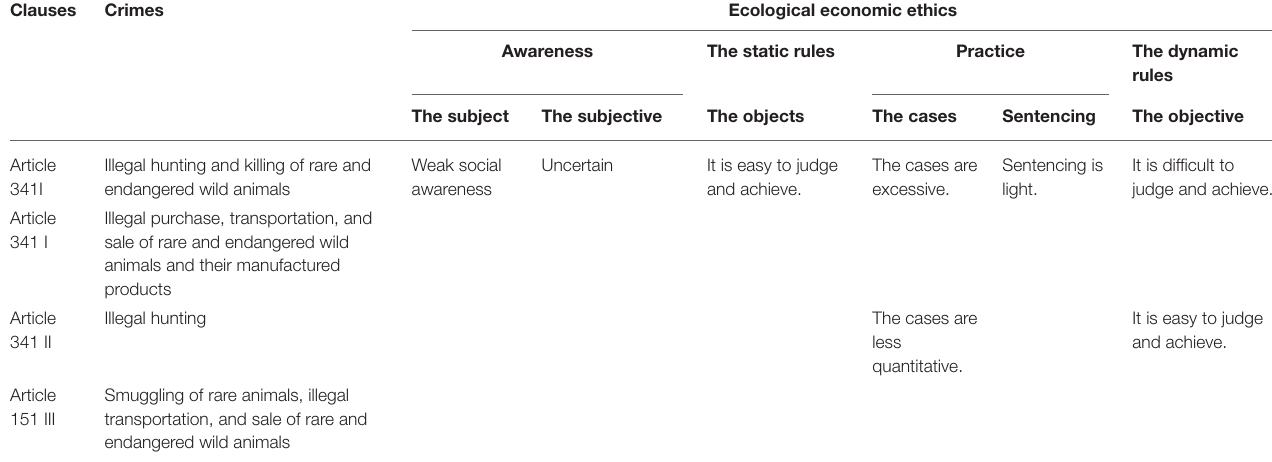
TABLE 9 | Ecological economic ethics dimensions of wildlife crimes